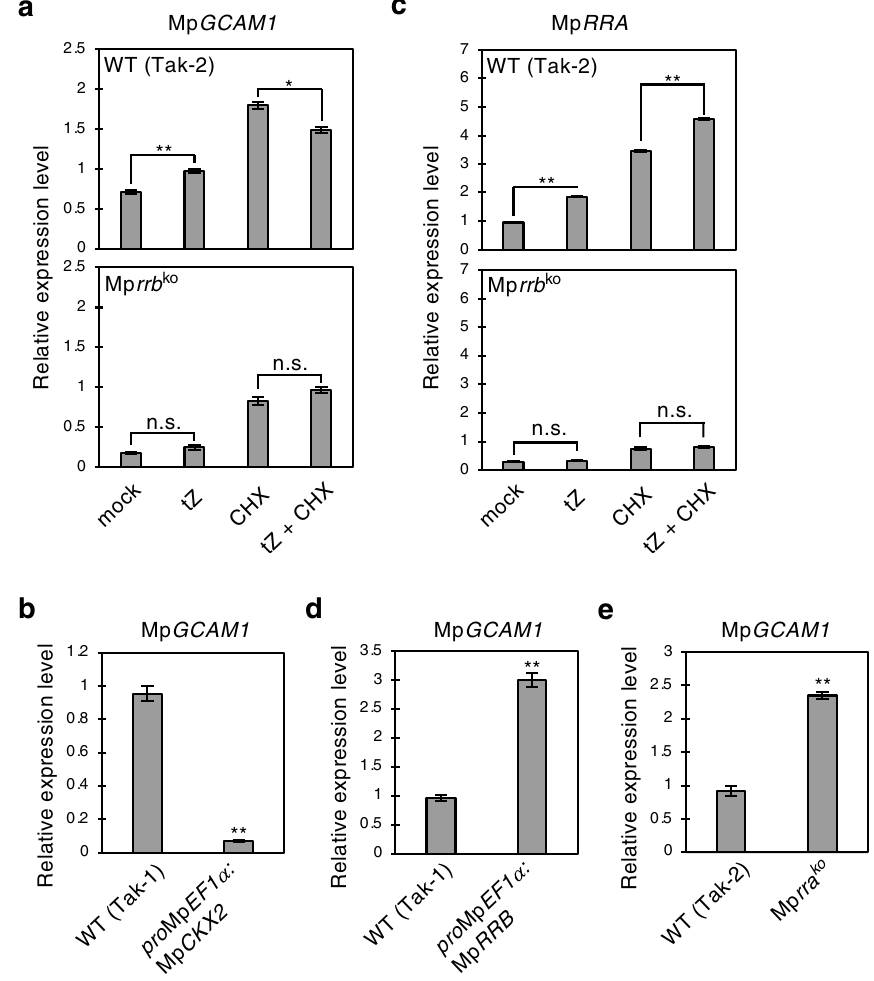
Figure 2. Mp GCAM1 transcript levels in tZ-treated plants, Mp CKX2 - or Mp RRB -overexpressing plants, and the Mp rra knockout mutant. ( a ) Transcript levels of Mp GCAM1 in the wild-type (Tak-2) and the Mp rrb knockout line with or without 50 µM of tZ treatment and/or 10 µM of CHX for 3 h. ( b ) Transcript levels of Mp GCAM1 in plants overexpressing Mp CKX2 . ( c ) Transcript levels of Mp RRA in the wild-type (Tak-2) and the Mp rrb knockout line with or without 50 µM of tZ treatment and/or 10 µM of CHX for 2 h. Transcript levels of Mp GCAM1 in ( d ) plants overexpressing Mp RRB and in the ( e ) Mp rra knockout line. mRNA levels were normalized to that of Mp EF1α . Data are presented as mean ± SD ( n = 3). Significant differences from the plants with ( a,c ) mock or CHX treatment and from the ( b,d,e ) wild-type were determined by Student’s t-test as follows: * P < 0.05; ** P < 0.01; n.s. not